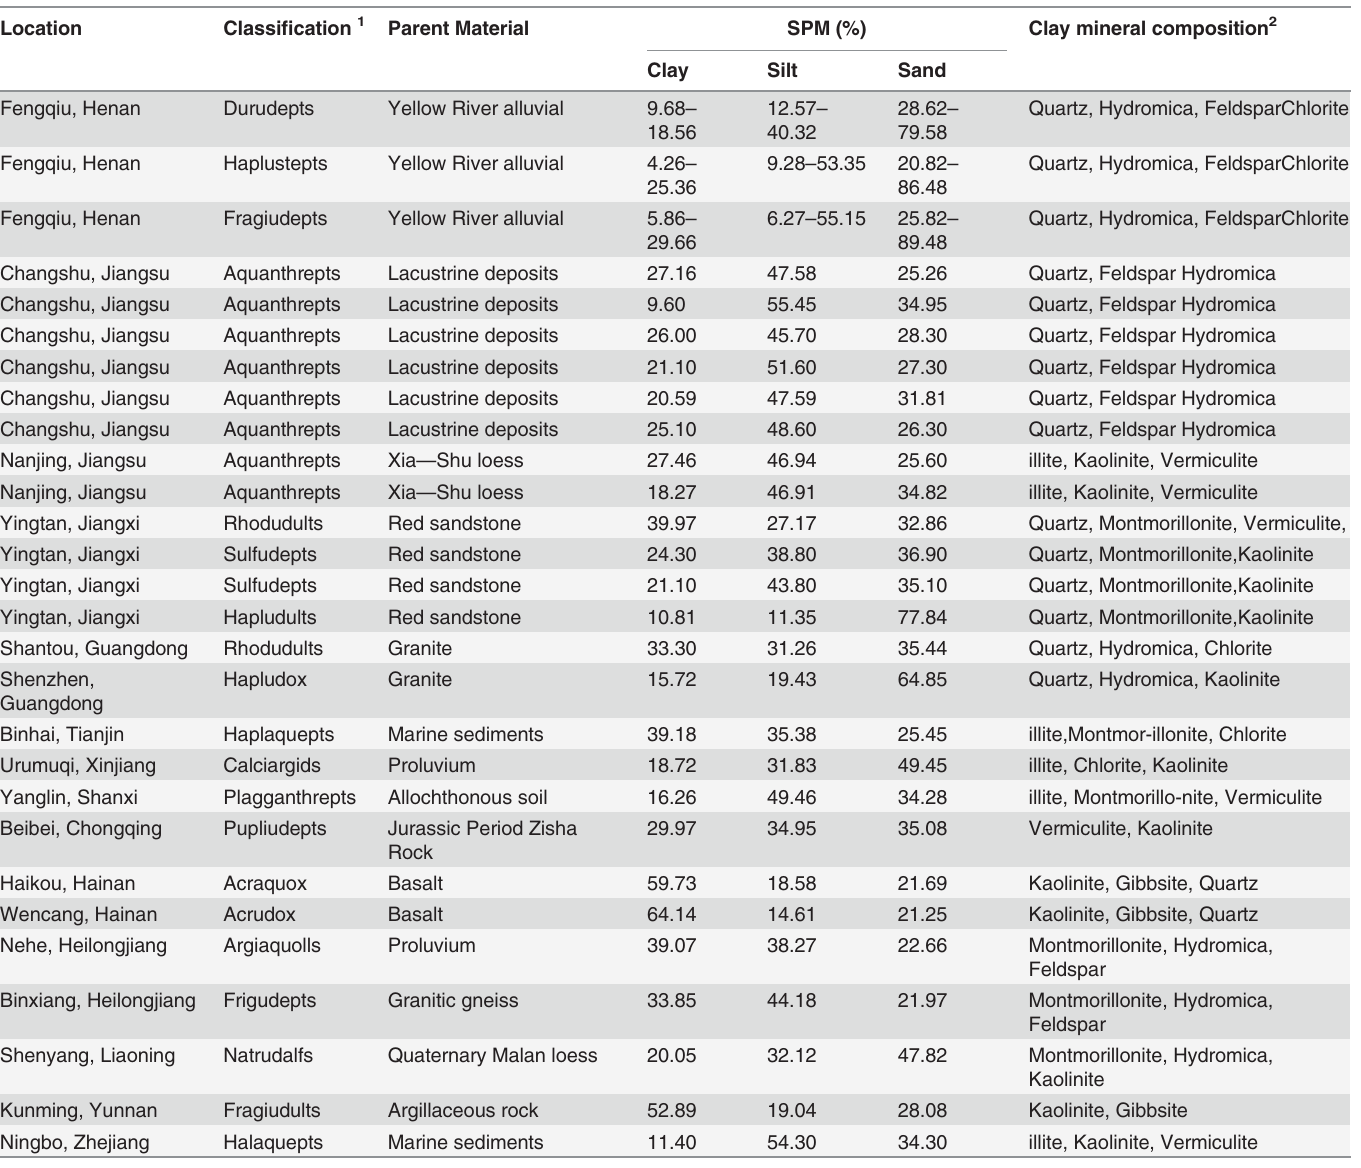
Table 1. General characteristics of the different types of soils